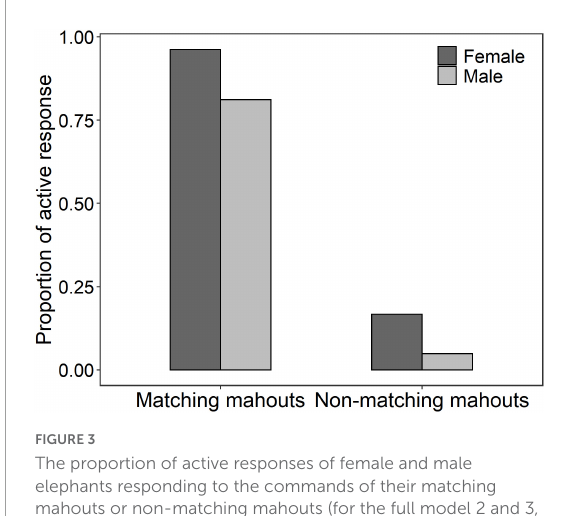
FIGURE3 The proportion of active responses of female and male elephants responding to the commands of their matching mahouts or non-matching mahouts (for the full model 2 and 3, see Table 2 ).